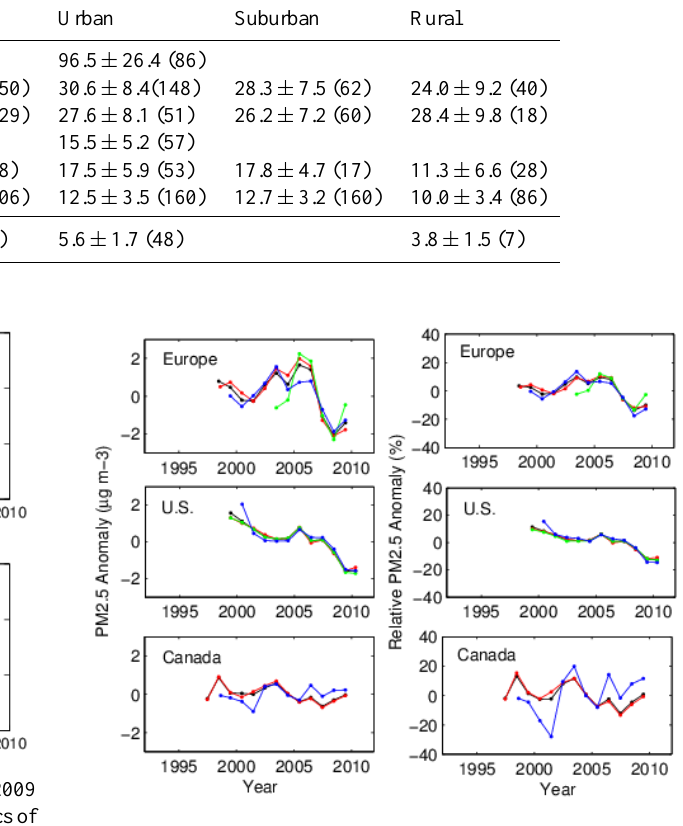
Figure 6. Annual anomalies (left) of PM2.5 and their relative anomalies Fig. 6. Annual anomalies (left) of PM 2 . 5 and their relative anoma- (normalized by multi-year-averaged PM2.5 value from each site). Black lines lies (normalized by multi-year-averaged PM 2 . 5 value from each represent averages over total sites, red lines represent urban averages, green lines site). Black lines represent averages over total sites, red lines rep- represent suburban averages, and blue lines represent rural averages. Multi-year resent urban averages, green lines represent suburban averages, and regional averages of PM2.5 can be found in Table 1. blue lines represent rural averages. Multi-year regional averages of PM 2 . 5 can be found in Table